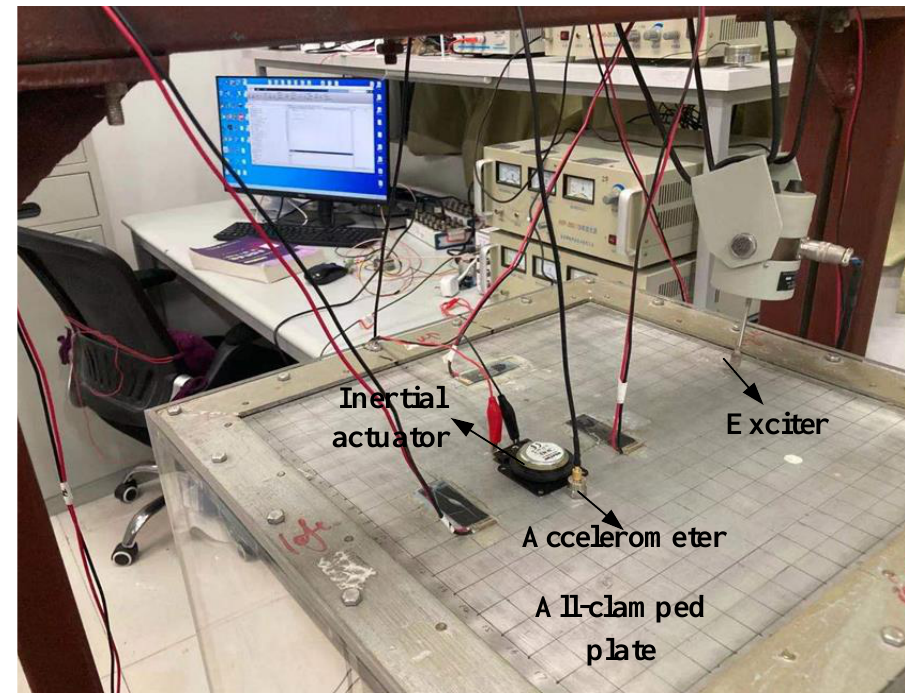
Figure 4. The equipment of the structure.